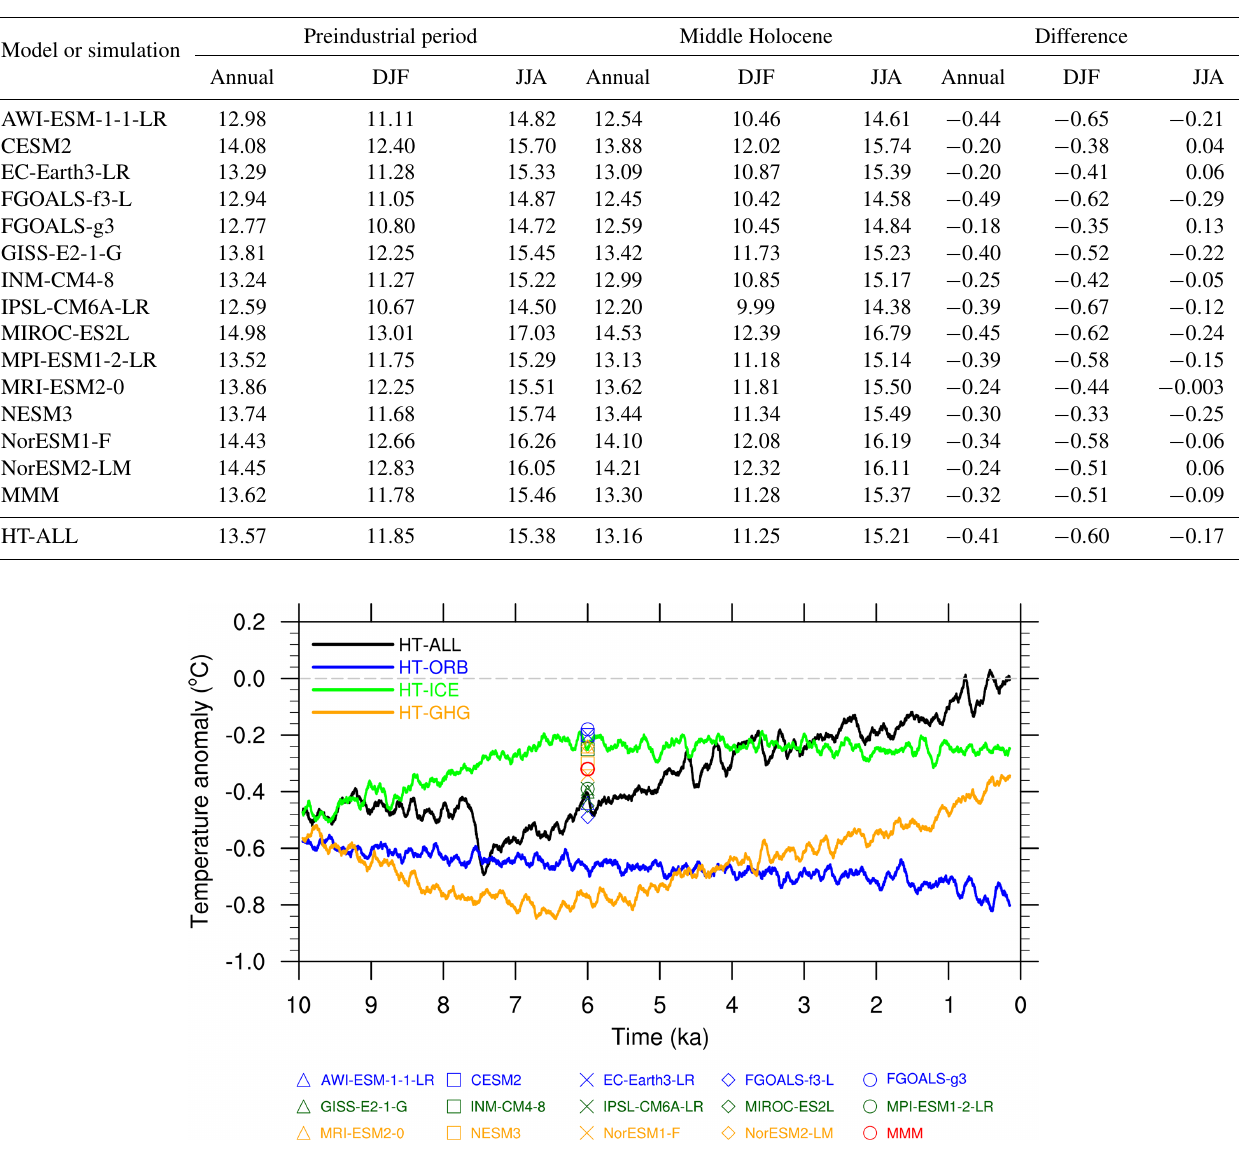
Table 3. Global annual, DJF, and JJA mean surface air temperatures (units in ◦ C) for the preindustrial period, Middle Holocene, and the difference between the Middle Holocene and preindustrial periods in simulations from the 14 PMIP4 models, their arithmetic mean (MMM), and HT-ALL. In the HT-ALL simulation, the preindustrial and Middle Holocene refers to the average for 1750–1850 and 6ka ± 0.05ka, respectively.